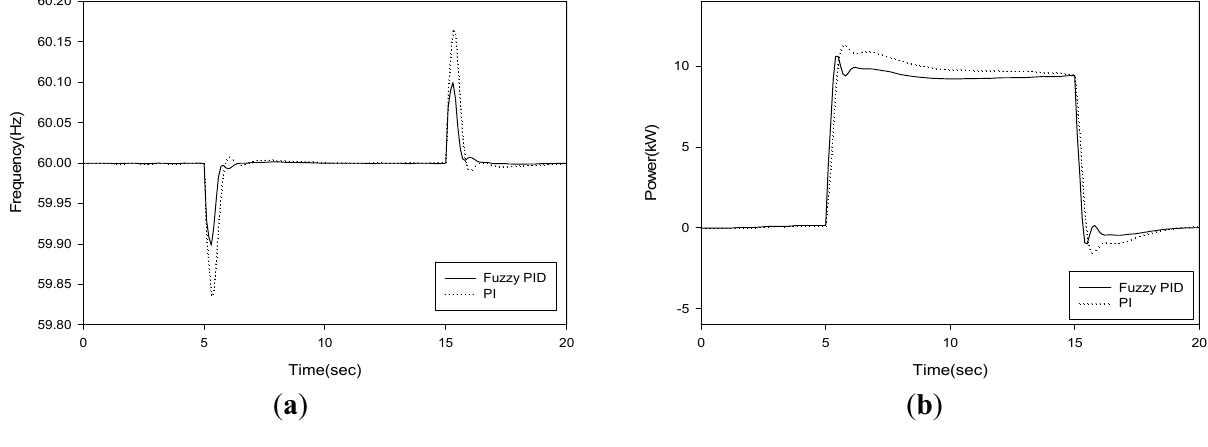
Figure 16. Simulation results in Case B: ( a ) Frequency deviation; ( b ) Power output of the